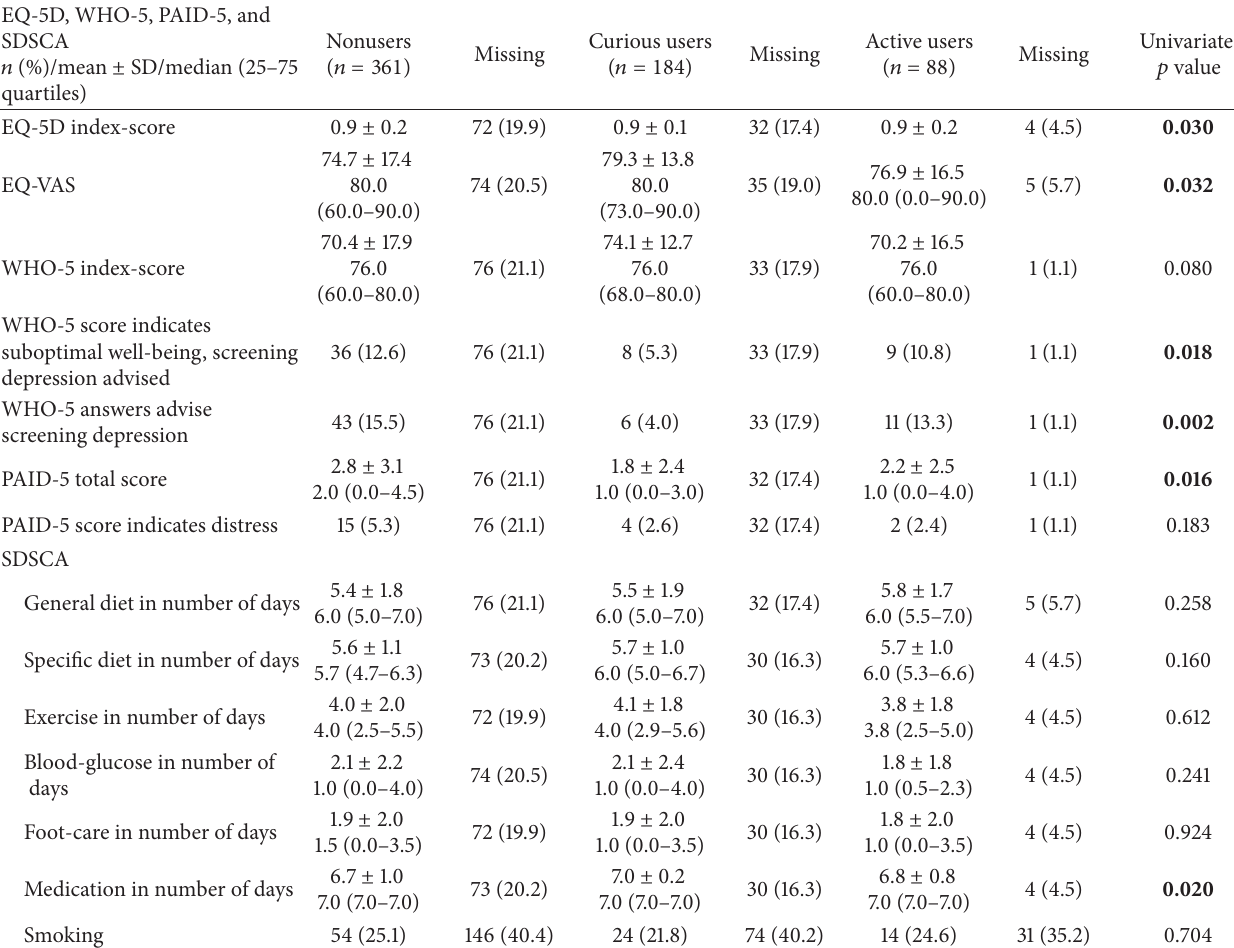
Table 13: Scores on quality of life (EQ-5D), well-being (WHO-5), diabetes-related distress (PAID-5), and self-care behavior (SDSCA) of curious users, active users, and